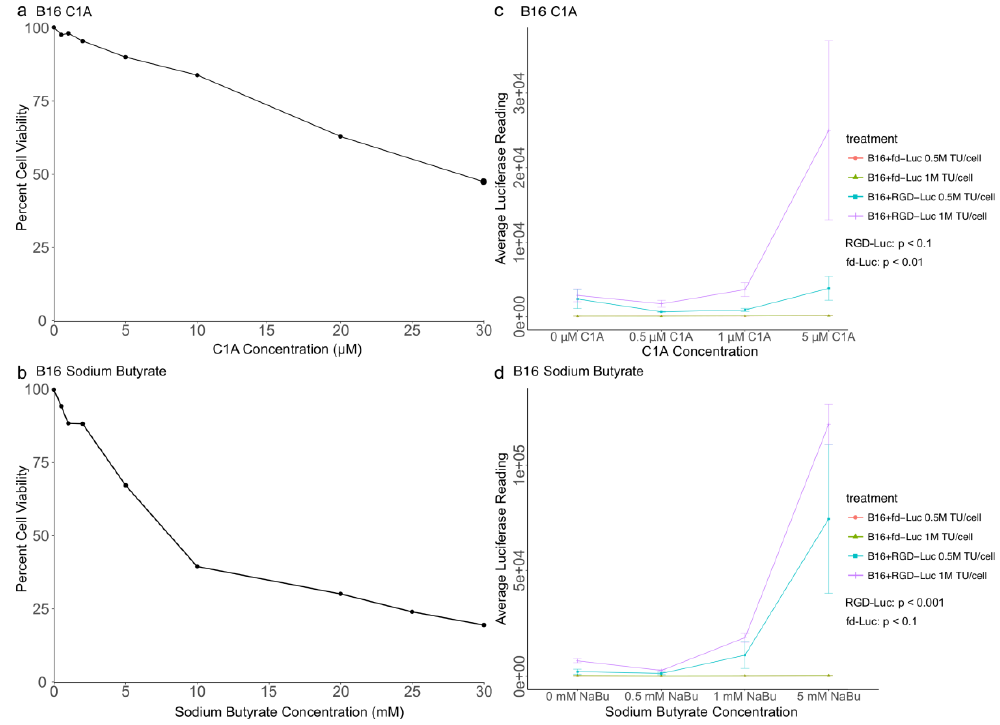
Figure 5. B16 cytotoxicity and luciferase assays. B16 cells were cultured in 96 well plates and treated with increasing concentrations of either C1A ( a ) or sodium butyrate ( b ). Cell viability percentages are relative to parallel control untreated cell cultures after 24 h. ( c , d ), luciferase assays at day 4 post transduction with targeted AAVP vector (RGD-Luc) or non-targeted AAVP (fd-Luc) expressing a Luc reporter gene at two different amounts of AAVP, 5 × 10 5 (0.5 million (M) TU/cell) and 1 × 10 6 (1 million (M) TU/cell) and increasing concentrations of either C1A ( c ) or sodium butyrate ( d ). Transgene expression was dependent on targeting and increased with dosage of adjuvant and with increasing AAVP TU. Experiments were carried out in triplicates and repeated twice. The vertical bars indicate standard deviation.